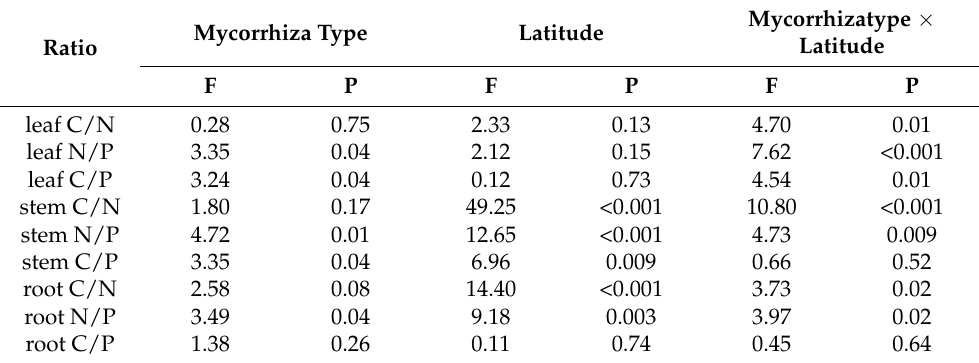
Table 1. The effect of mycorrhiza type, latitude, and their interaction on the C, N, and P concentration ratio in shrub organs based on linear mixed-effects